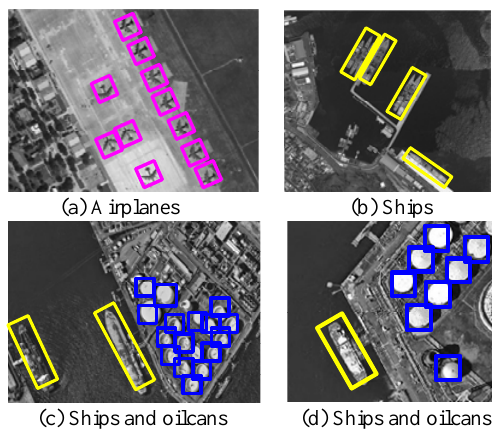
Figure 10. Interpretation results in harbour and airport scenes